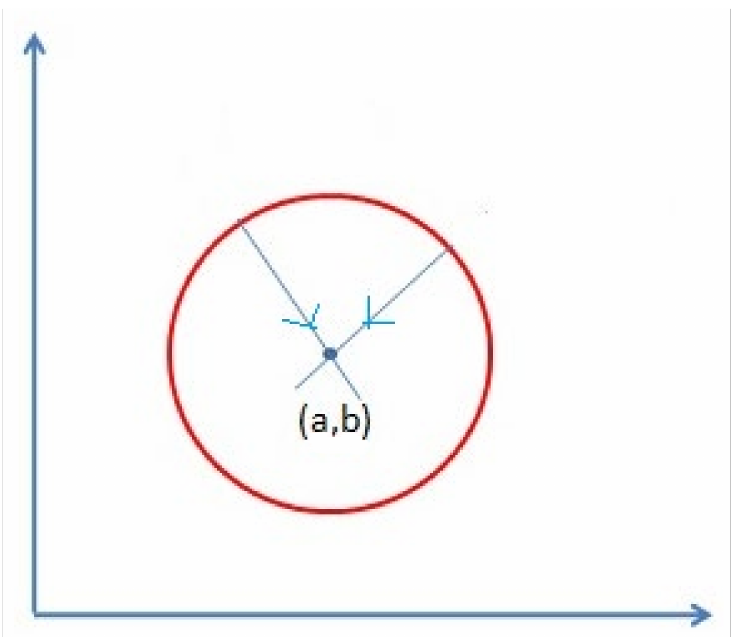
Figure 3. HSV color space.